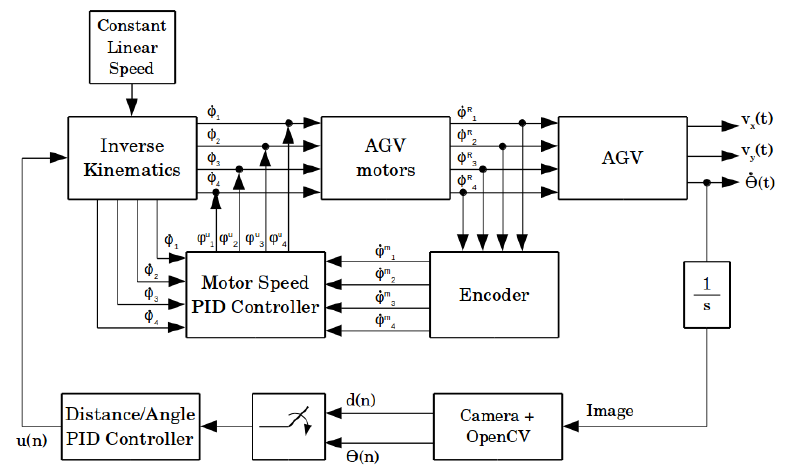
Figure 5. AGV control loop block